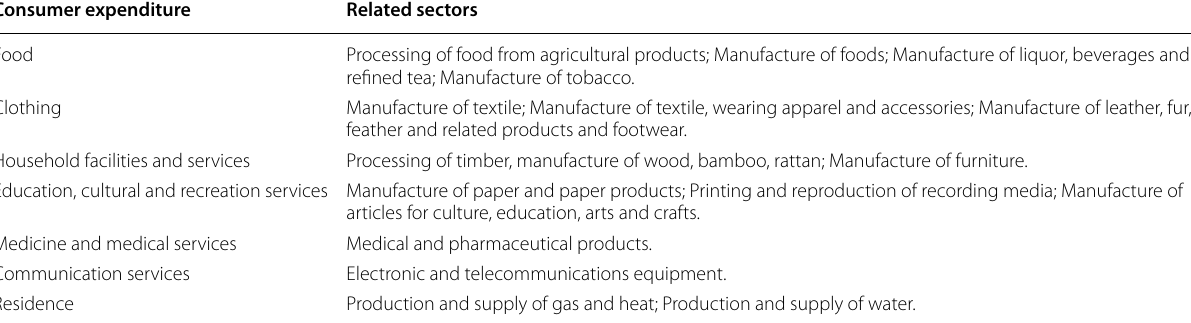
Table 1 Sectors related to household consumer behaviors Consumer expenditure Related